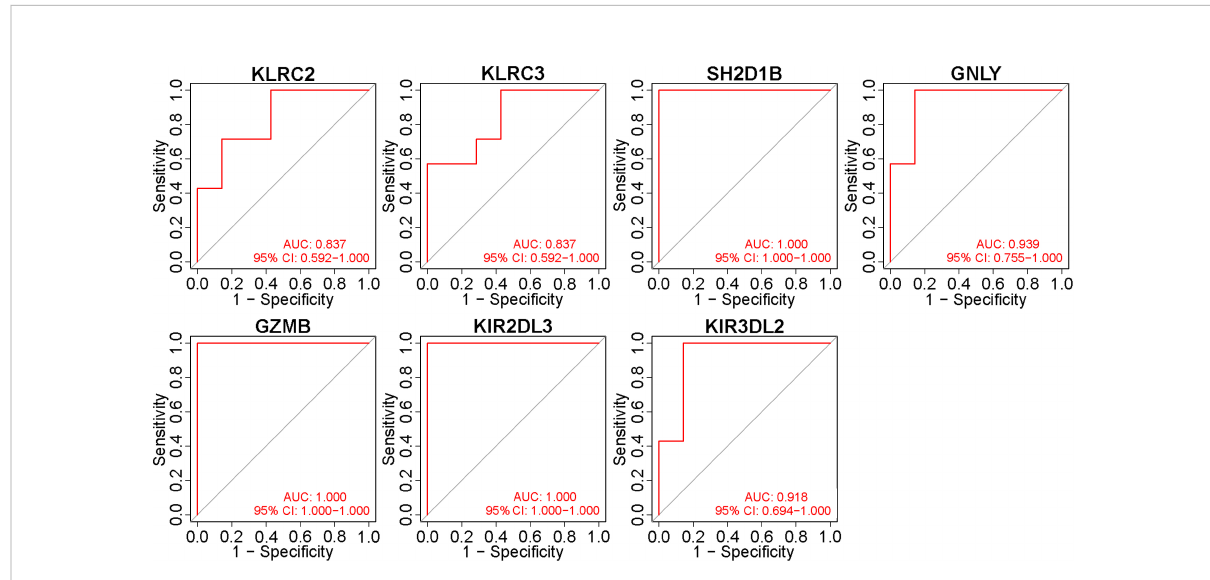
FIGURE 6 Validation of the diagnostic value of immune potential hub genes. Receiver operating characteristic values and area under the curve (AUC) statistics indicated that all seven potential hub genes had diagnostic value for Vogt-Koyanagi-Harada